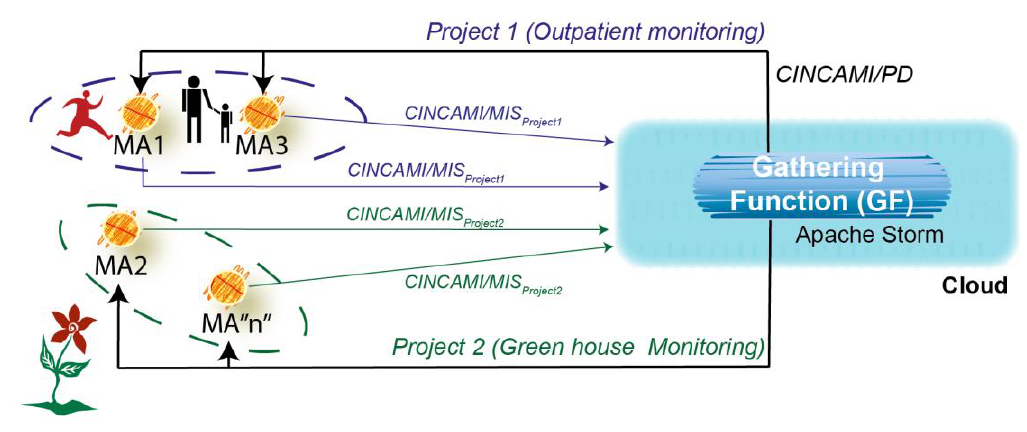
Figure 3. Conceptual description of the location of GF and MA and its impact on the data